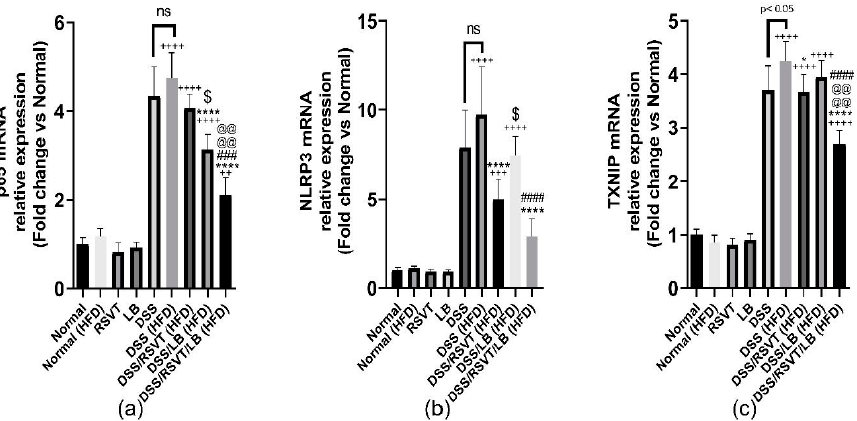
Figure 7. Effect of rosuvastatin (RSVT), Lactobacillus (LB), and their combined therapy on ( a – c ), the mRNA gene expression of p65, NLRP3, and TXNIP, respectively. ++, p < 0.01 vs Normal (HFD); +++, p < 0.001 vs. Normal (HFD); ++++, p < 0.0001 vs. Normal (HFD); *, p < 0.05 vs. DSS (HFD); ****, p < 0.0001 vs. DSS (HFD); ###, p < 0.001 vs. DSS/LB (HFD); ####, p < 0.0001 vs. DSS/LB (HFD); @@@@, p